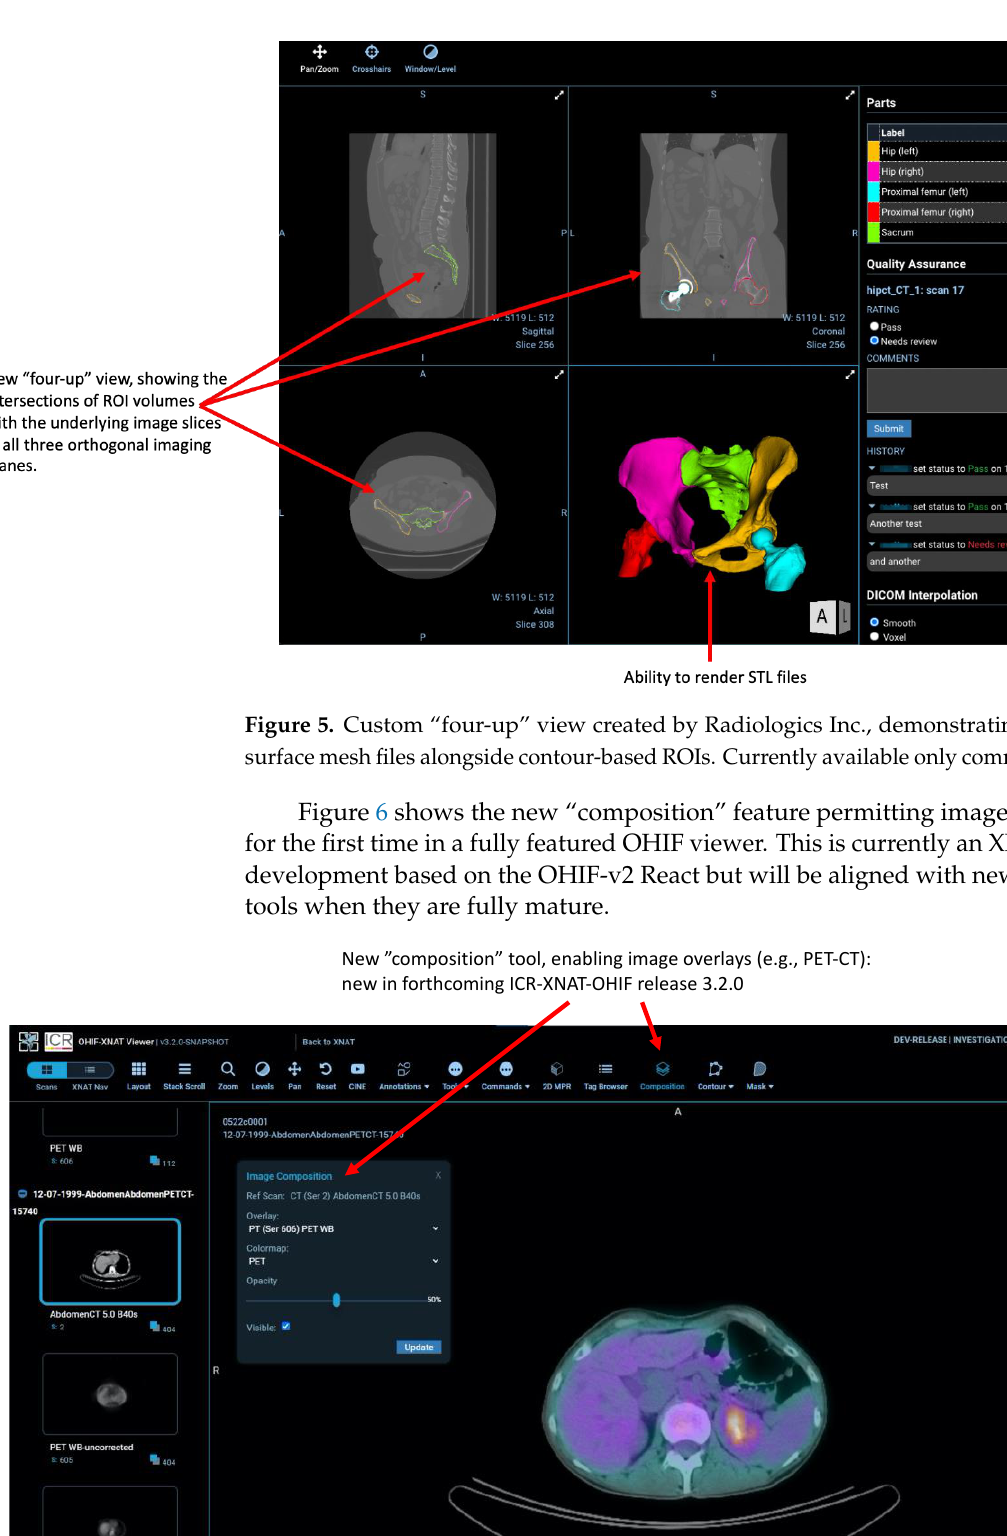
Figure 4. Display of DICOM fractional segmentation objects both in standard 2D mode and multi- planar reformatting (MPR) mode, also demonstrating the integration of a new XNAT project navi- gation sidebar and that 3D mask ROIs are rendered correctly in all three planes.